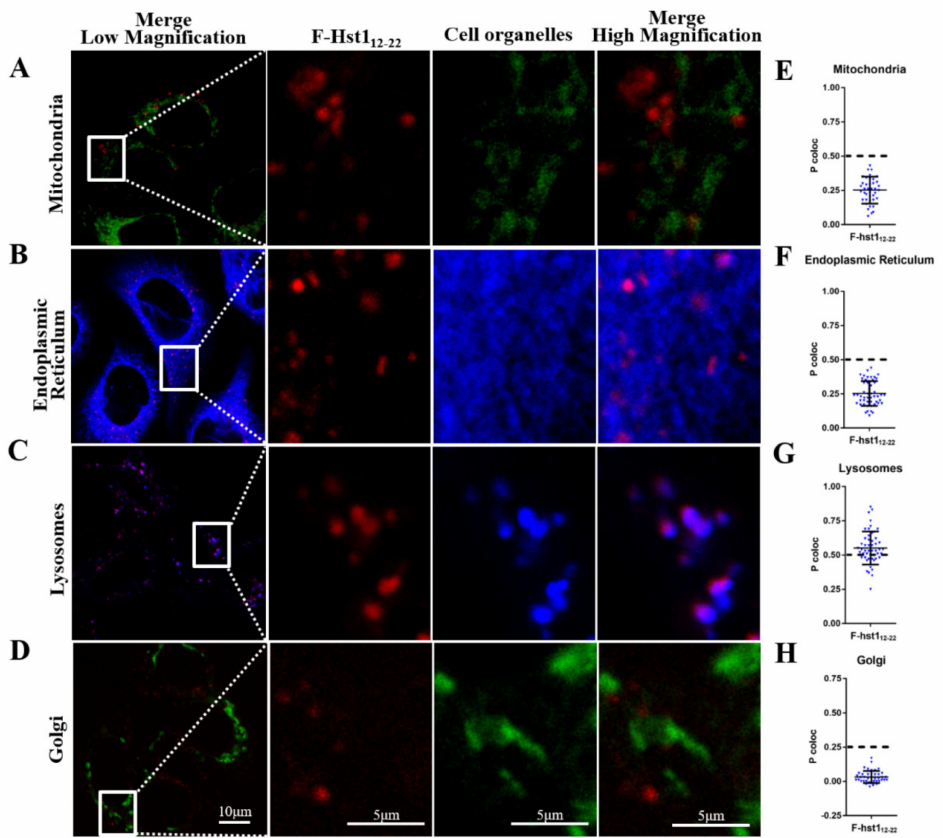
Figure 8. F-Hst1 12-22 was not targeted to mitochondria and endoplasmic reticulum (ER) in HO1N1 epithelial cells. ( A – D ) CLSM images showed that F-Hst1 12-22 showed co-localization with lysosomes (in blue) but not with mitochondria (in green) and ER (in blue) or Golgi (in green). ( E – H ) The Pearson’s correlation analysis showed that F-Hst1 12-22 co-localize with lysosomes with a P coloc value of about 0.55, but not with mitochondria, ER or Golgi (with P coloc values below 0.5). Data were presented as mean ±